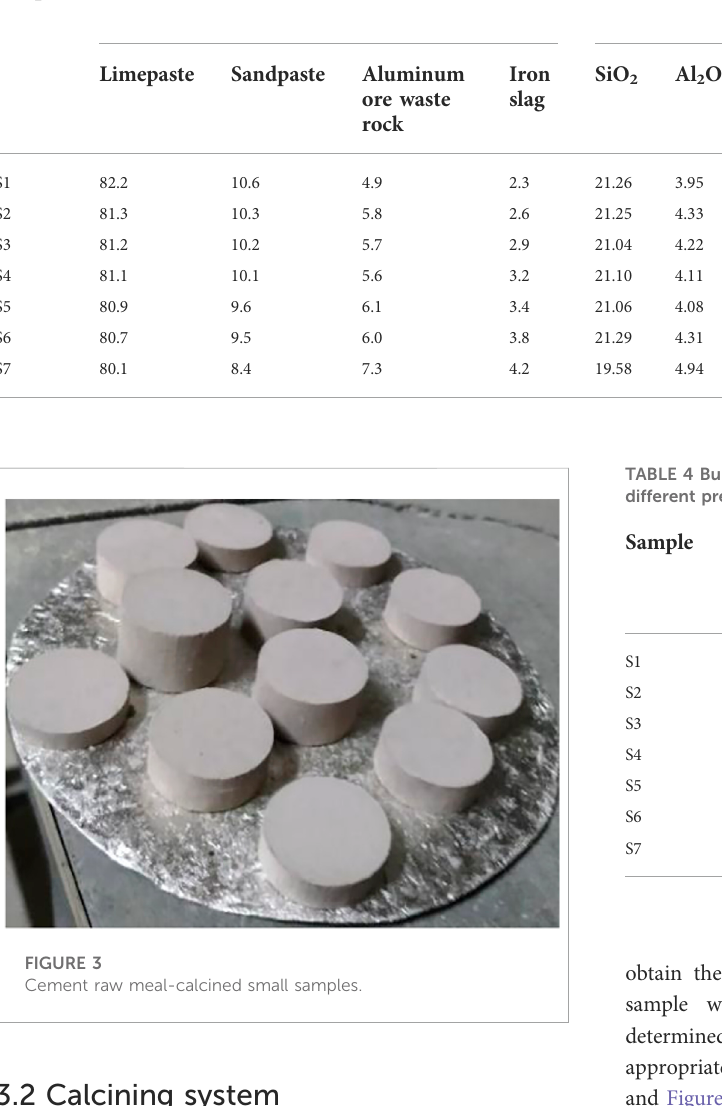
TABLE 3 Design of clinker mineral composition. Sample